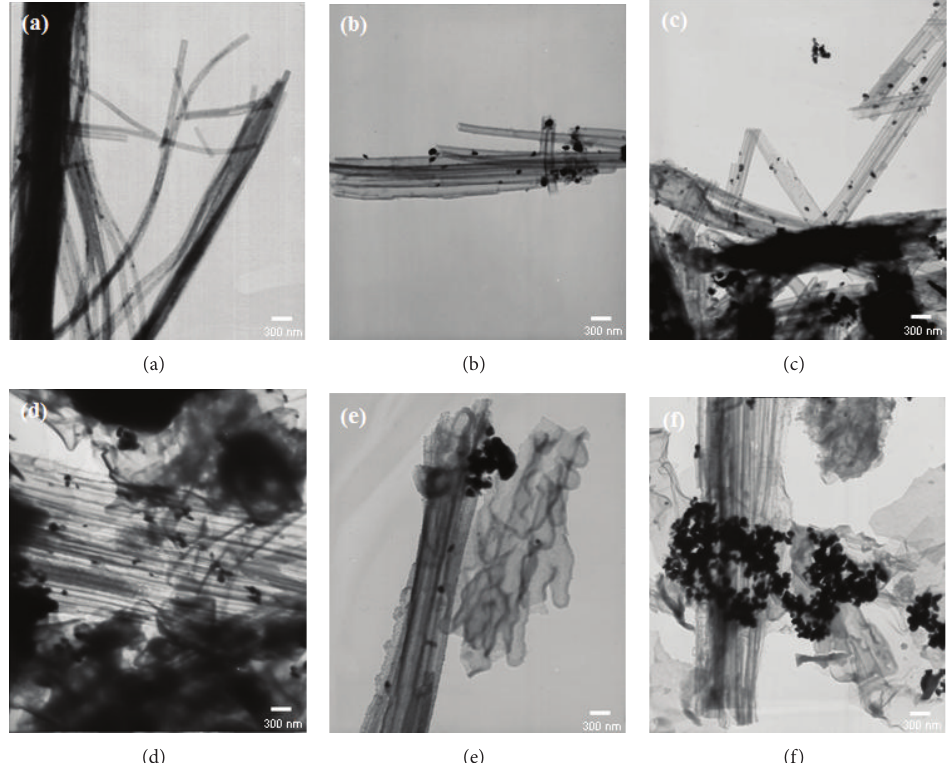
Figure 3: TEM images of HCl functionalized 𝛼 CNTH/Ag nanohybrids at different molars of AgNO 3 : (a) 0 M, (b) 0.01 M, (c) 0.05 M, (d) 0.1M, (e) 0.5 M, and (f) 1M.